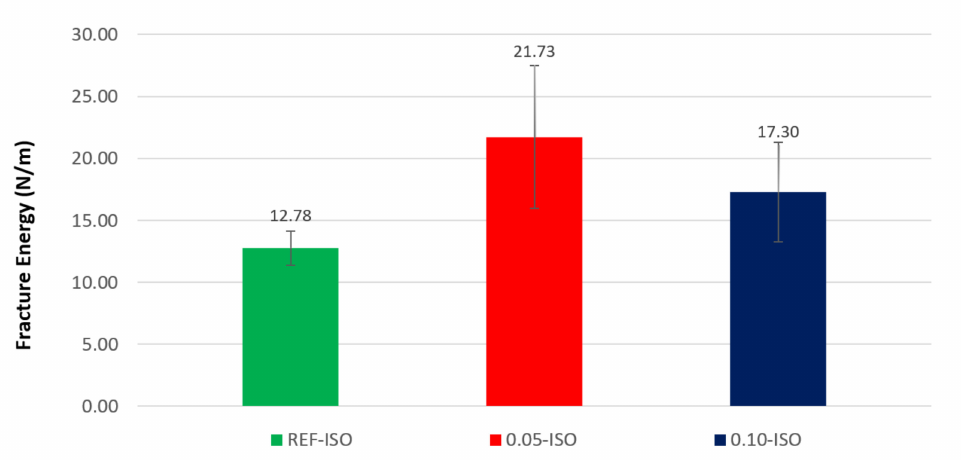
Figure 7. Fracture energy